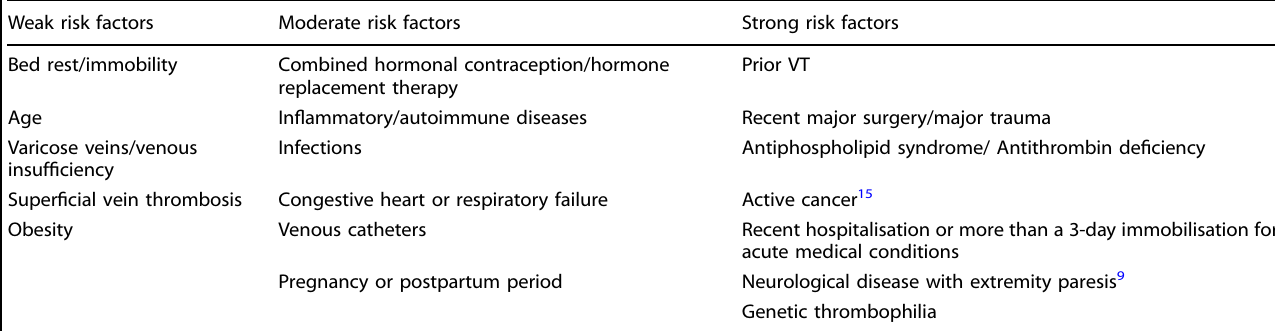
Table 1. VT risk factors on Earth. Categorized as strong (OR > = 10); moderate (OR 2 – 9) or weak (OR < 2) Adapted from Table 3, Ortel et al. 28 . Weak risk